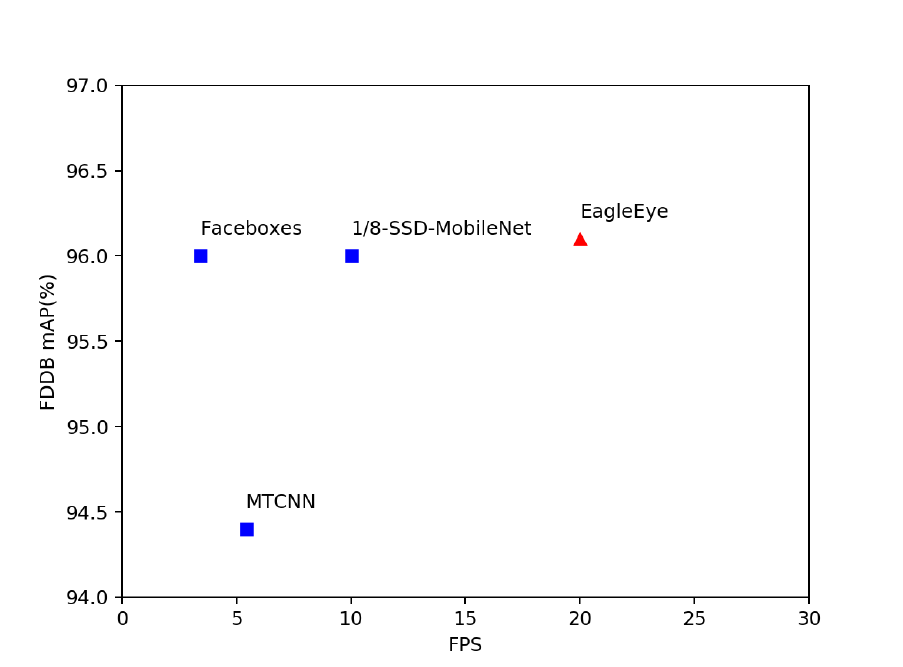
Figure 5. Speed (frames per second (FPS)) versus accuracy (mAP) on FDDB dataset. The speed (FPS) is tested on the ARM Cortex-A53 based embedded device.